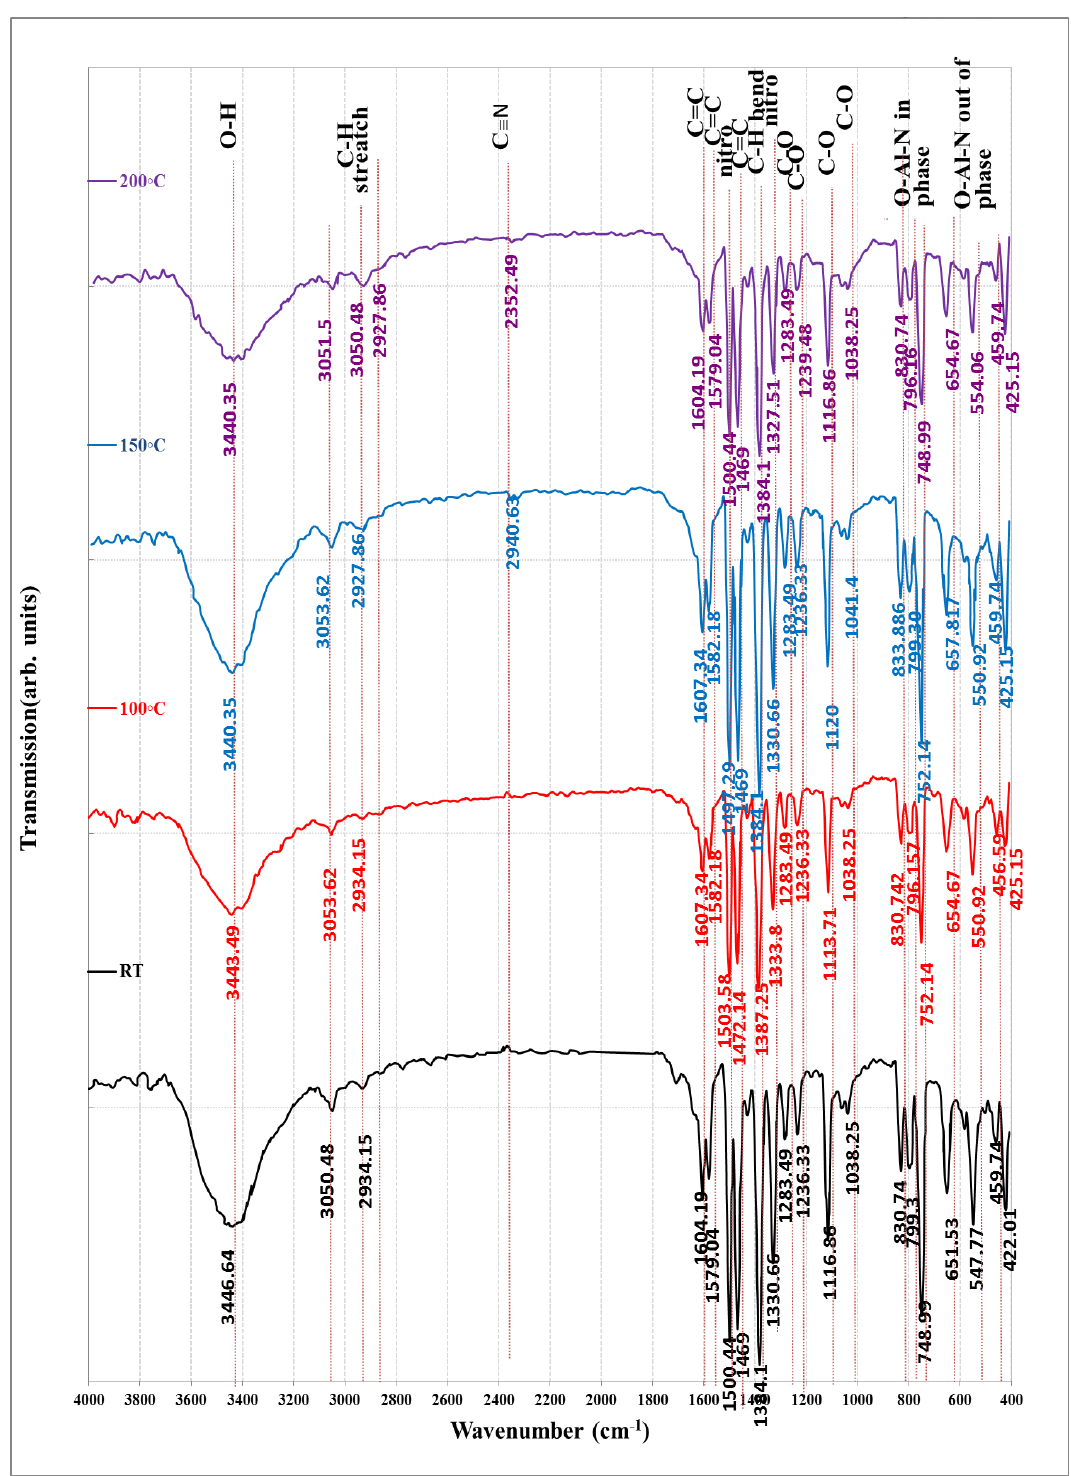
Fig. 7: FTIR for Alq